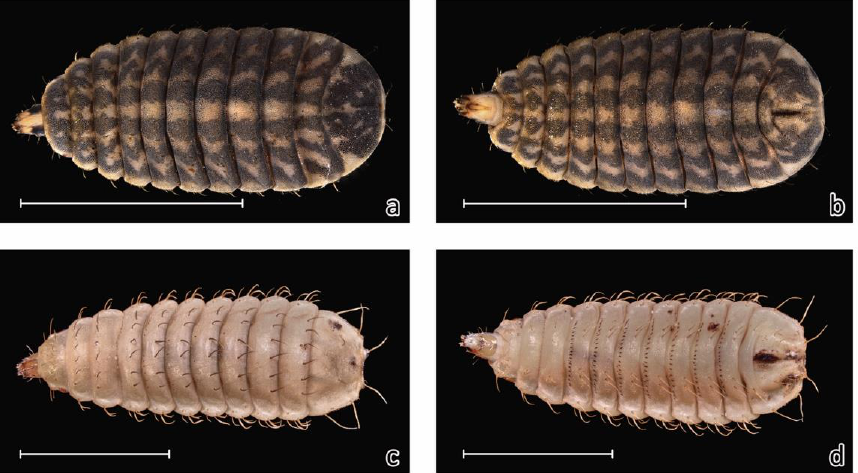
Figure 4. Third instar larvae of Sargus bipunctatus . ( a ): upperside, ( b ): underside and Hermetia illucens , ( c ): upperside, ( d ): underside. Scale bar: 5 mm. Photos—M. Michalski.